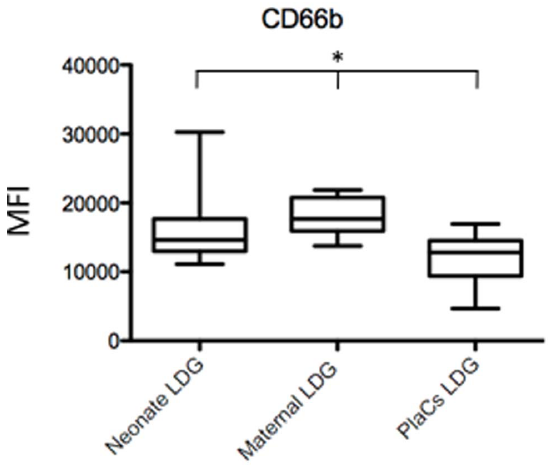
Figure 2. Comparison of the phenotype of LDGs in neonate and maternal blood and placentae. LDGs were isolated as described in materials and methods (n=7) and the expression levels of CD66b was determined by flow cytometry. Statistical significance was determined by a kruskal-Wallis test. Box=interquartile range and median; whiskers=range.